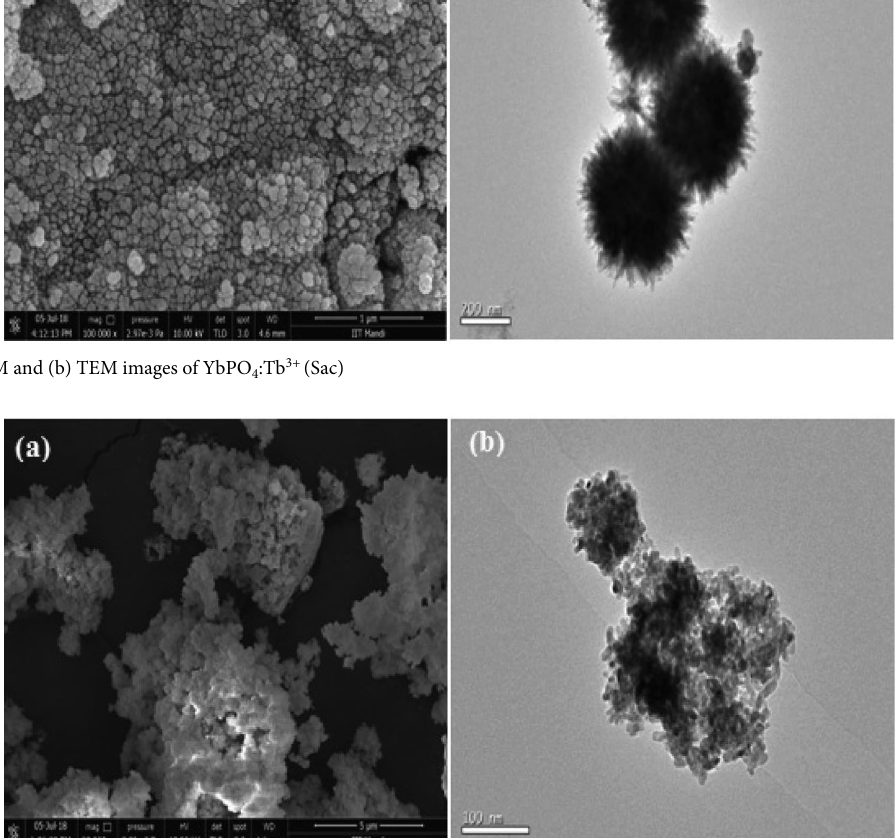
flakes like morphology of particle size ~ 170 nm. The na- norods like morphology of YbPO 4 :Tb 3+ of size 600 × 80 nm was obtained via hydrothermal method (Fig 5). The YbPO 4 :Tb 3+ samples synthesized by solvothermal and co-precipitation method show the nanoparticles like mor-